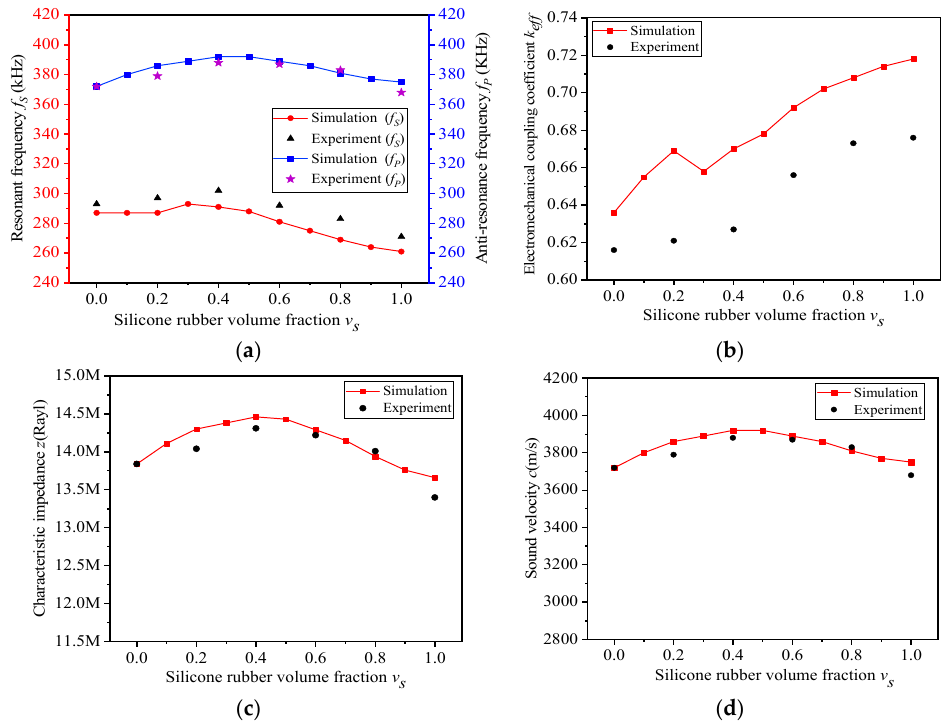
Figure 8. ( a – d ) Experiment performance of composite with different v s (v c = 0.4).